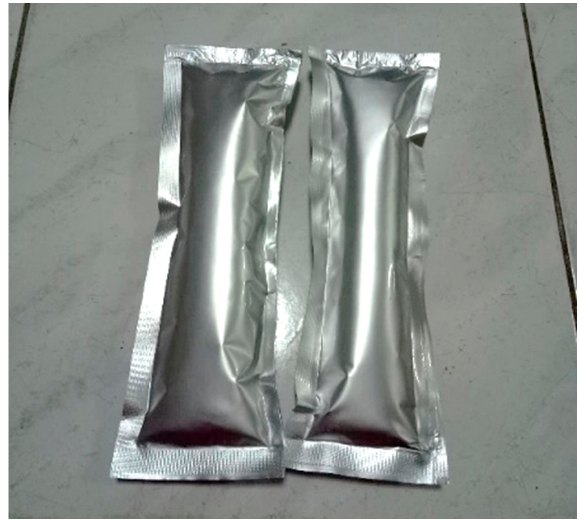
Figure 6. Aluminum foil bag with PCMs .